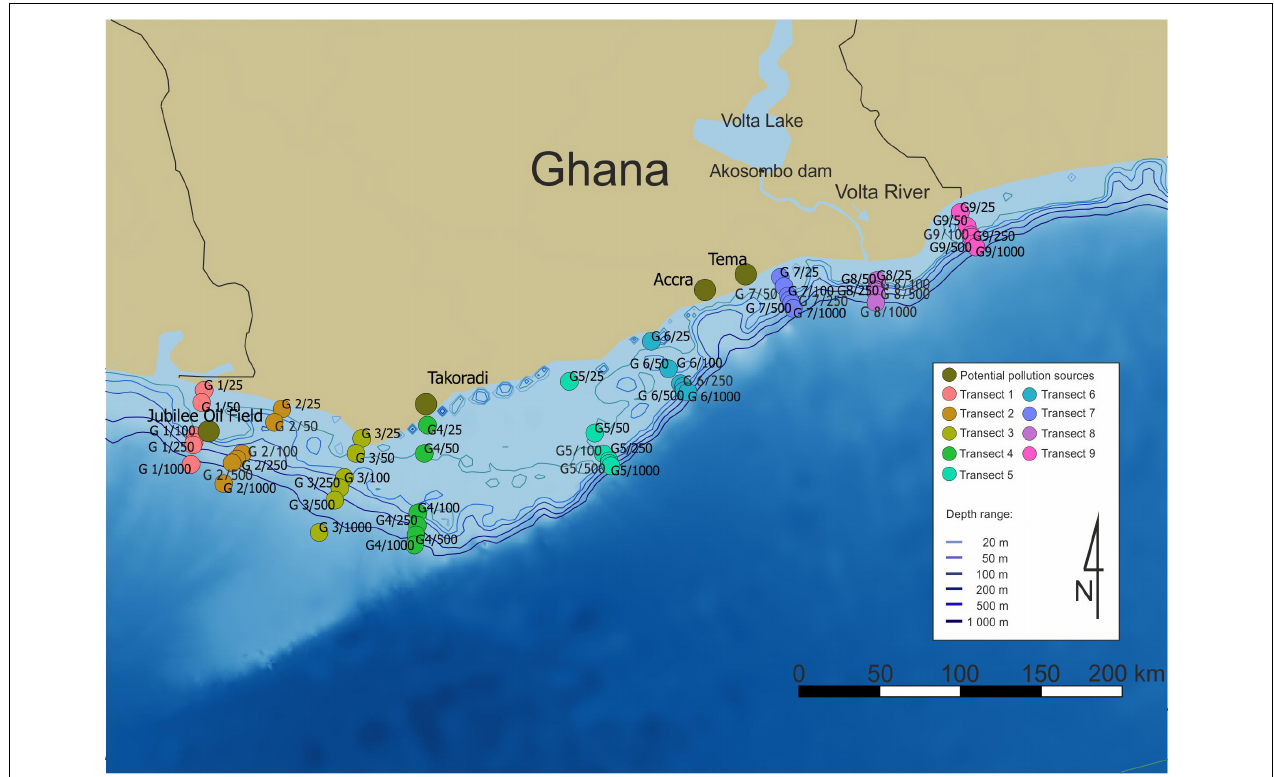
FIGURE 1 | Distribution of sampling stations along the Ghanaian